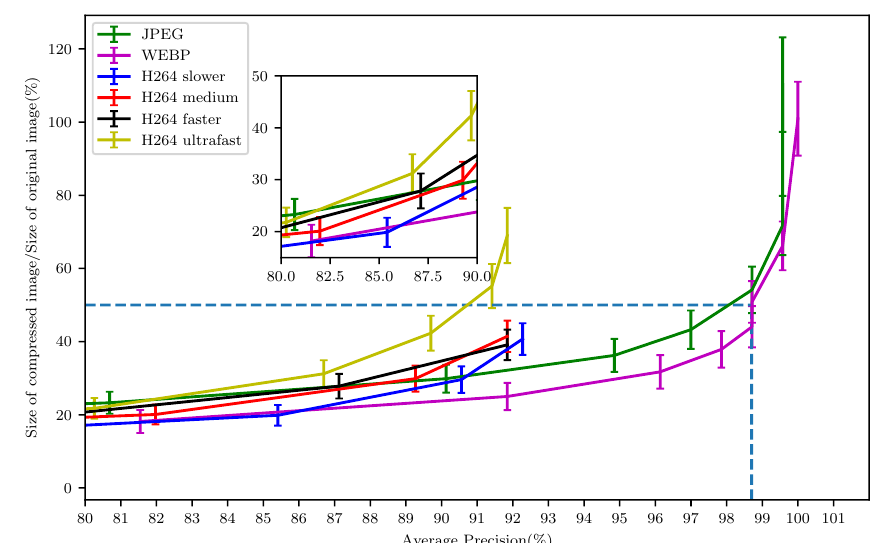
Figure 6. Image-based compression methods for JPEG input assumption, from